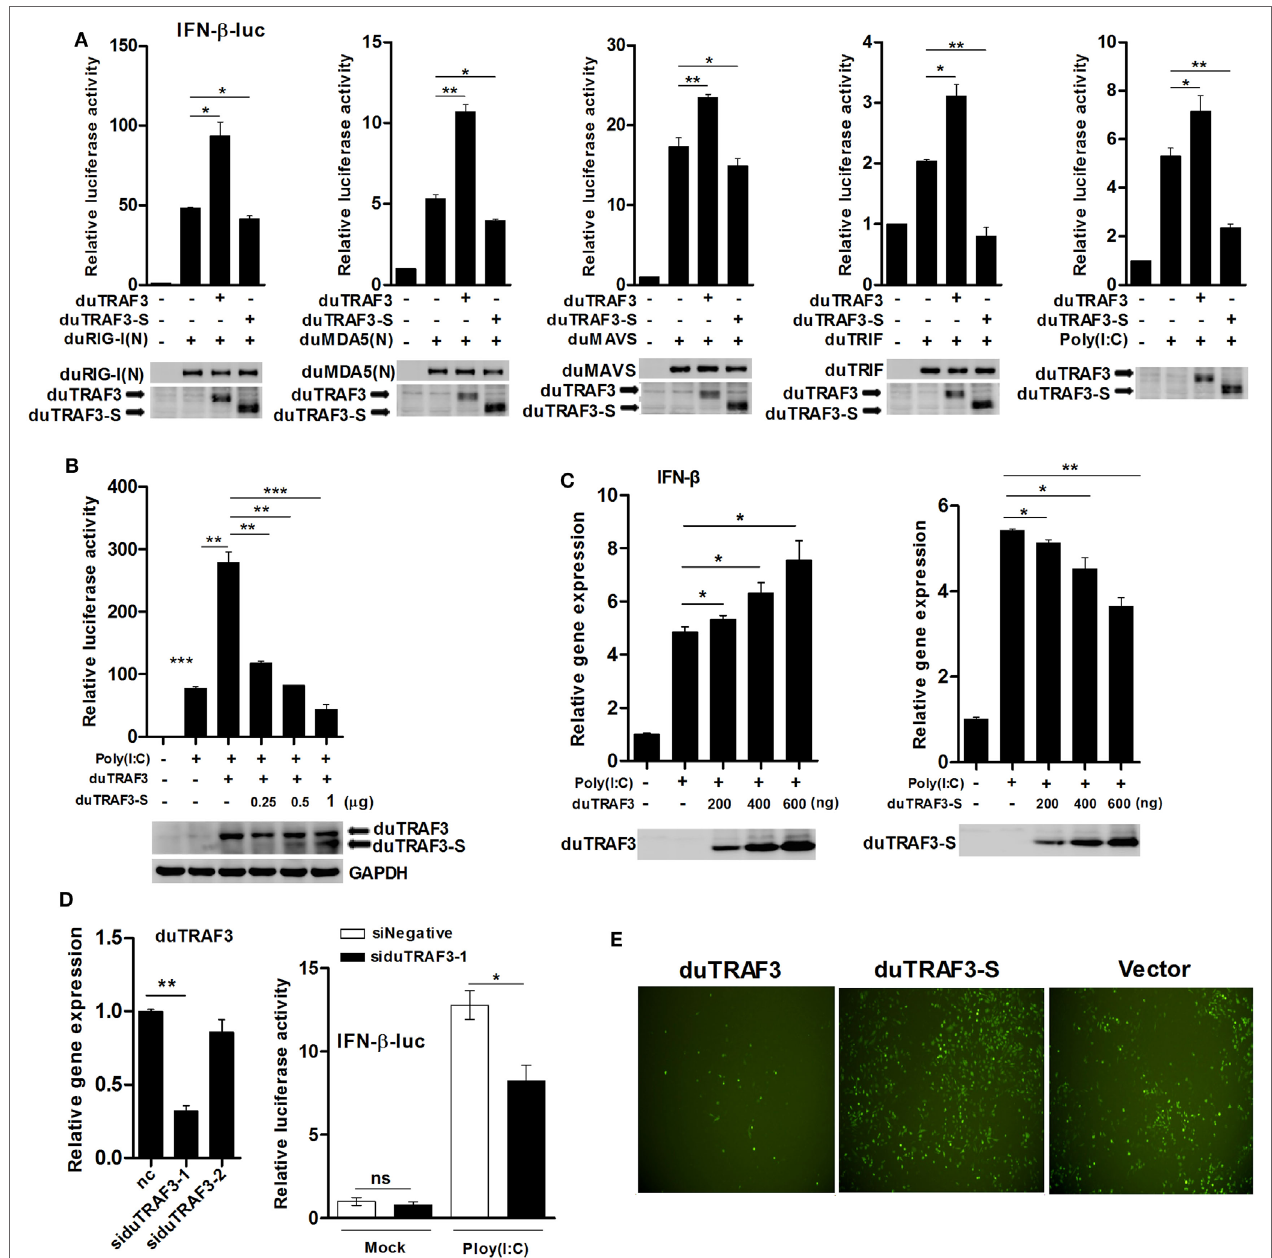
FigUre 3 | Duck TRAF3s (duTRAF3s) activated interferon (IFN)- β transcription, and spliced isoform of duTRAF3 (duTRAF3-S) inhibited IFN- β activation. (a) Duck embryo fibroblasts (DEFs) were transfected with an empty vector, duTRAF3, or duTRAF3-S along with IFN- β -luc and pRL-TK for 24 h, and cells were then transfected with duRIG-I(N), duMDA5(N), duMAVS, or duTRIF for 24 h or transfected with poly(I:C) for 16 h. (B) DEFs were transfected with duTRAF3 or an increasing amount of duTRAF3-S as indicated for 24 h and then transfected with poly(I:C) for 16 h. Then the luciferase activity was detected. (c) DEFs were transfected with increasing amounts of plasmids encoding duTRAF3 and duTRAF3-S (200, 400, 600 ng) for 24 h, cells were transfected with poly(I:C) for 16 h, and then the transcription of IFN- β was measured. Western blot analysis of lysates was performed. (D) DEFs were transfected with two duTRAF3 siRNA (60 pmol) for 24 h, and then total RNAs were extracted to examine the mRNA levels of duTRAF3 transcripts by qPCR. DEFs were transfected with negative control siRNA or duTRAF3 siRNA (si-1) together with IFN- β reporter and pRL-TK plasmids for 24 h, then transfected with poly(I:C), and luciferase activity was measured at 16 h posttransfection. The relative firefly luciferase activity was normalized to the renilla luciferase activity, and the untreated empty vector control value was set to 1. Data are represented as mean ± SD. Experiments were repeated for three times. Student’s t -test was performed to determine the P value. * P < 0.05; ** P < 0.01; *** P < 0.001. (e) DEFs were transfected with expression plasmids for duTRAF3, duTRAF3-S, or empty vector. At 24 h after transfection, the cells were infected with vesicular stomatitis virus encoding green fluorescence protein (VSV-GFP) [multiplicity of infection (MOI) of 0.1]. Twelve hours later, GFP expression was visualized by fluorescent